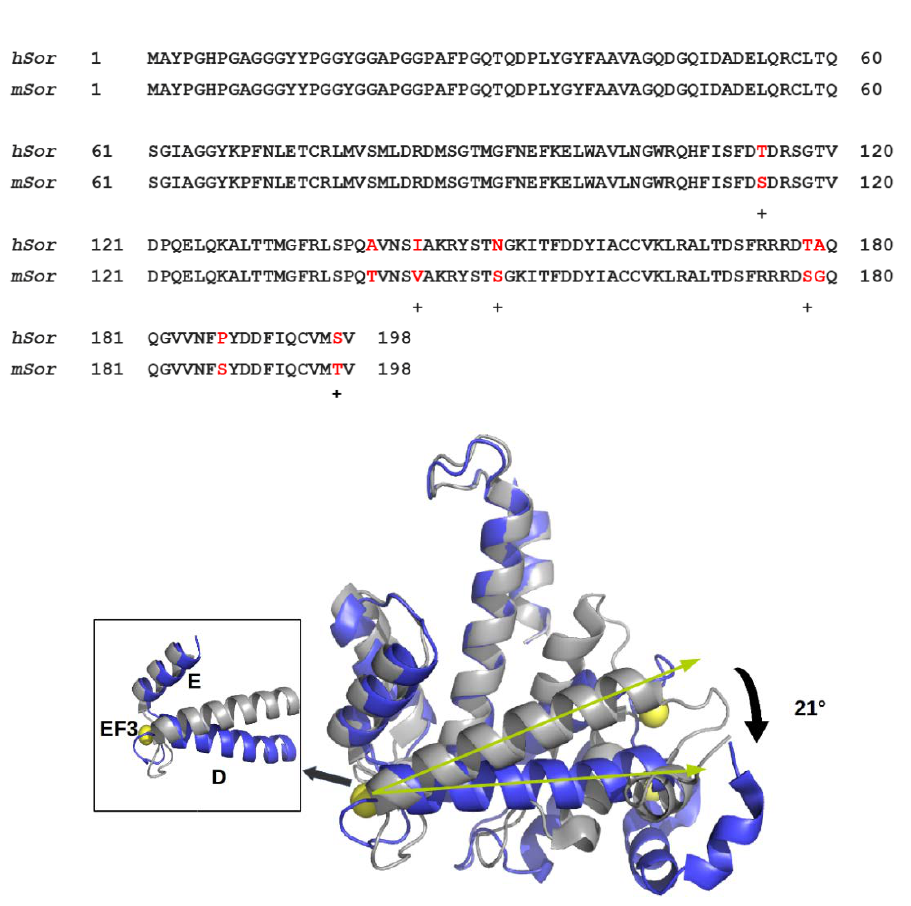
Figure 2. Upper panel. Alignment between human sorcin ( hSor ) and mouse sorcin ( mSor ). The variant residues are indicated in red. The “ + ” indicates residues with similar characteristics. Lower panel. The X-ray crystal structure of human sorcin in the apo form (gray) and in the calcium-bound form (blue; calcium ions are represented by yellow spheres). Upon calcium binding, sorcin activation occurs, with a transition from a closed to an open structure (see also detail of the EF3 hand), involving a movement of the long D-helix of 21°.